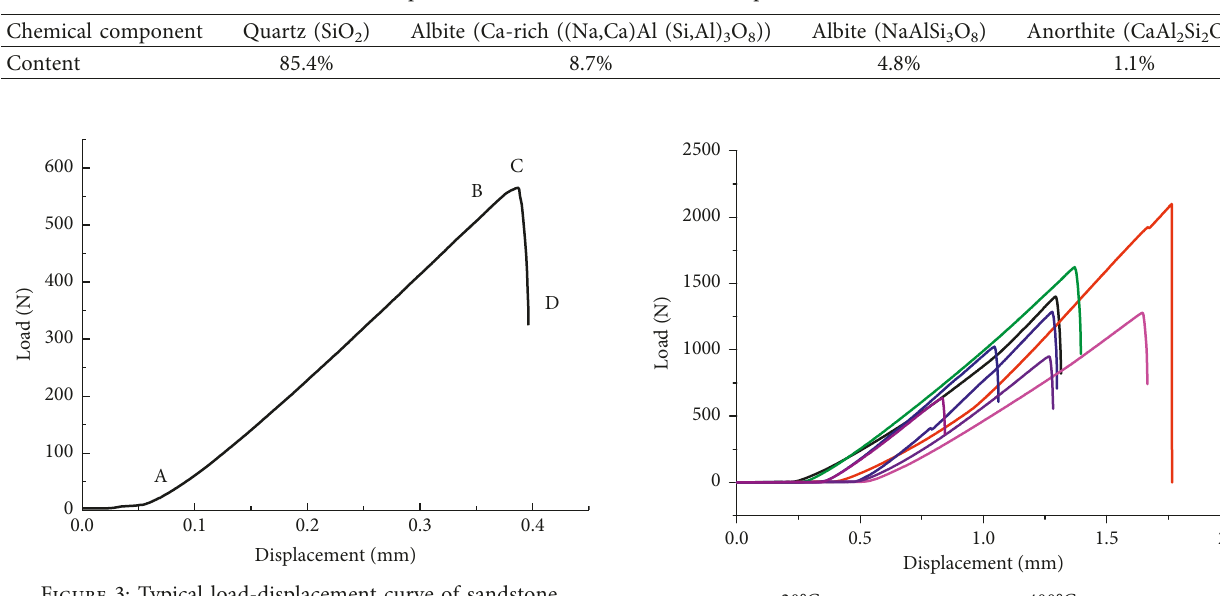
Table 1: Compositions and contents of the tested specimens (mean value).